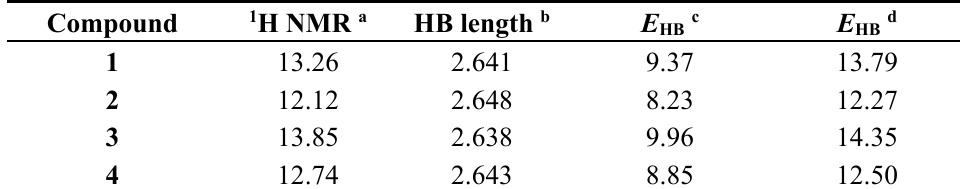
Table 1. Calculated and experimental parameters for 1 – 4 .